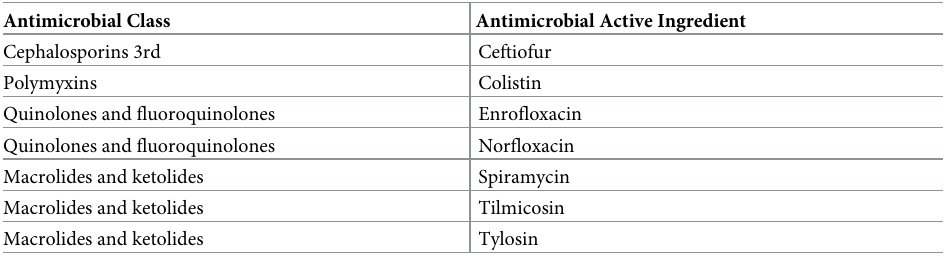
Table 1. Critically important antimicrobials with highest priority (CIA-HtP) identified at surveyed dairy and broiler